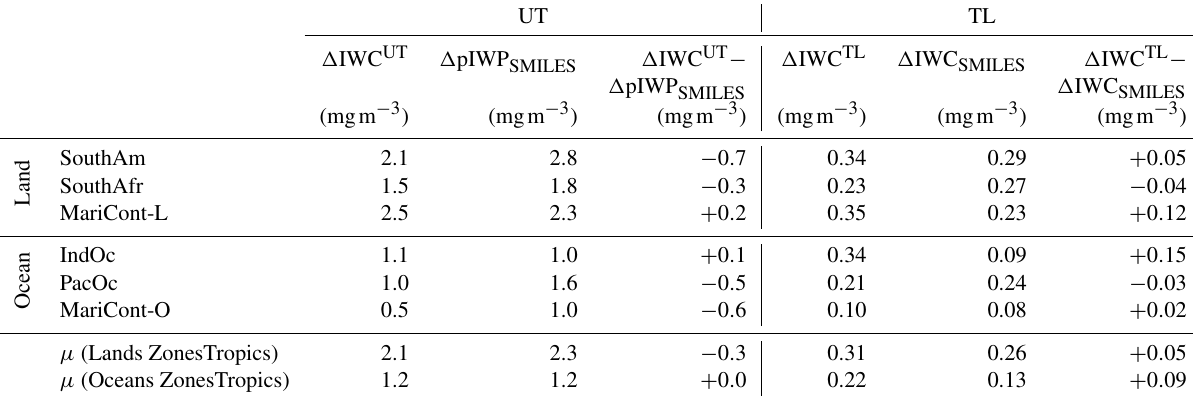
Table 2. Differences between the amount of ice water content (IWC) estimated by the TRMM and the MLS injected into the upper tropo- sphere (UT) and the tropopause layer (TL) ( (cid:49) IWC UT and (cid:49) IWC TL , respectively), and partial ice water path (pIWP) measured by SMILES in the UT ( (cid:49) pIWP SMILES ) and IWC measured by SMILES in the TL ( (cid:49) IWC SMILES ), during the period DJF 2009–2010, and their differ- ences ( (cid:49) IWC UT − (cid:49) pIWP SMILES and (cid:49) IWC TL − (cid:49) IWC SMILES , in the UT and the TL, respectively). The averages over the land and ocean zones ( µ (Lands ZonesTropics) and µ (Oceans ZonesTropics), respectively) are also presented. UT